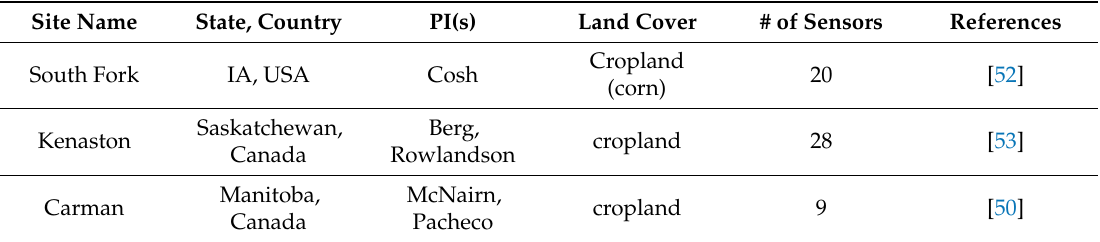
Table A3. Data used for Tb validation with SMAPL2 Enhanced H-pol brightness temperature.